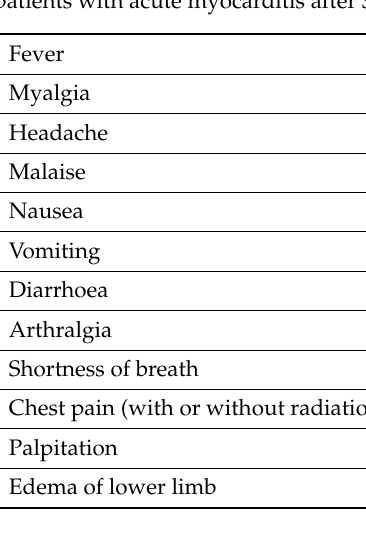
Table 1. Potential cardiovascular and non-cardiovascular symptoms reported as initial symptoms in patients with acute myocarditis after SARS-CoV-2